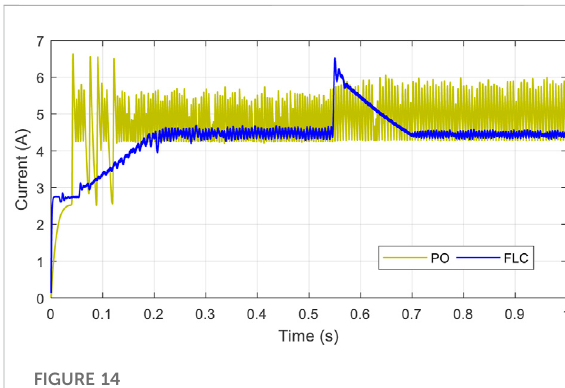
FIGURE 14 Experimental currents for both FLC and P&O controls.